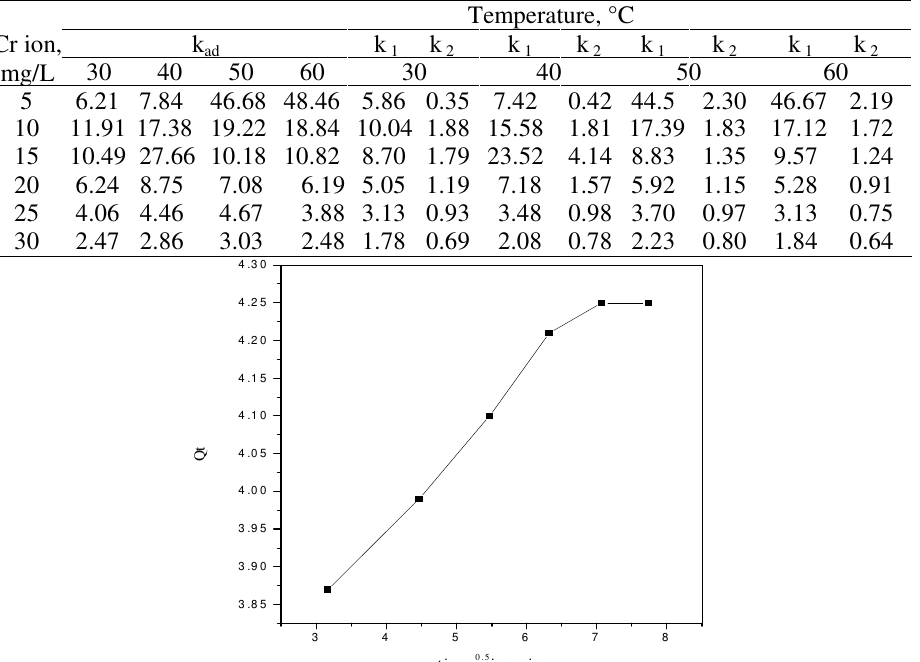
Table 7. Rate constants for the adsorption of chromium ion (10 3 k for forward (10 3 k , min -1 ) and reverse (10 3 k 1